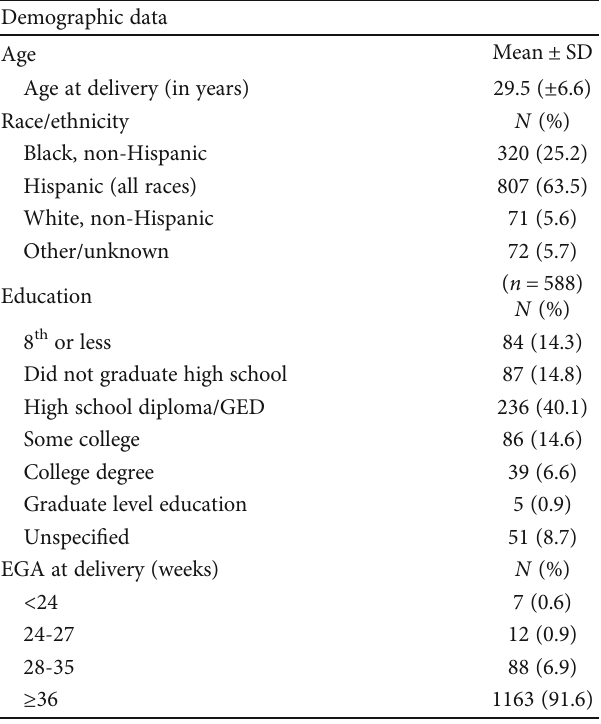
Table 1: Characteristics of the patient population. Age at delivery, race/ethnicity, and estimated gestational age were identi fi ed for all 1270 patients. Education level was identi fi ed for 588 patients of the